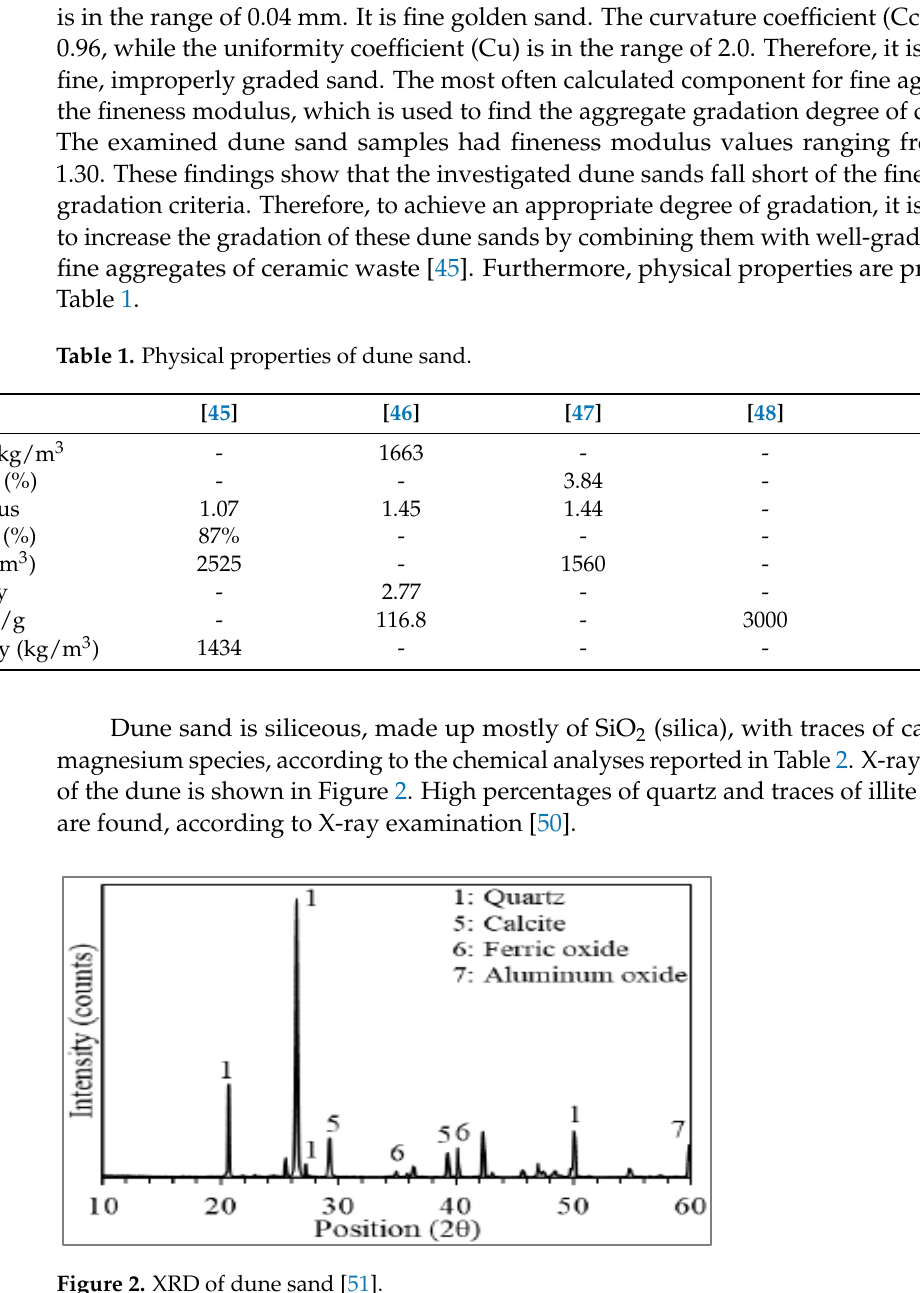
Table 1. Physical properties of dune sand.